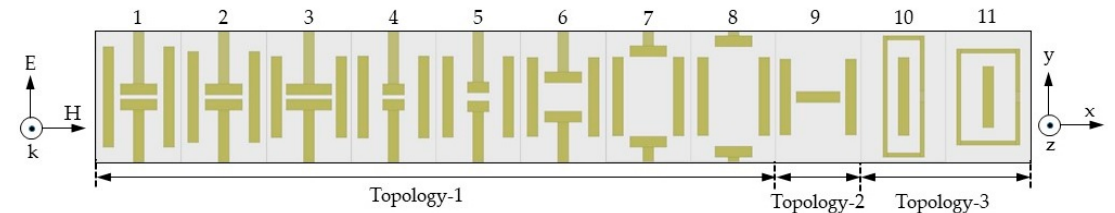
Figure 10. Top view of 11 unit cells with topologies 1, 2, or 3.